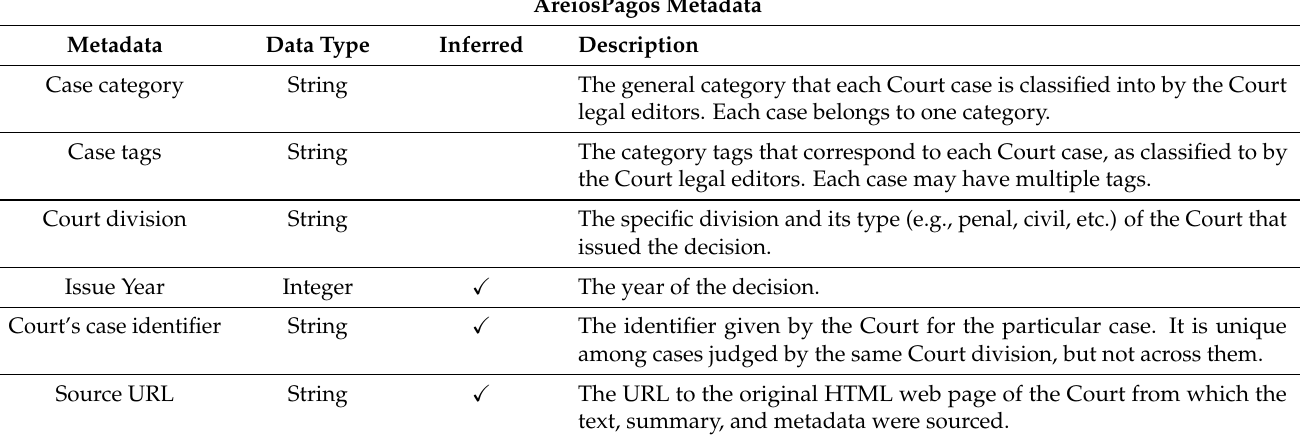
Table 2. Metadata of the Supreme Civil and Criminal Court judgments’ (AreiosPagos) dataset. Metadata that were automatically inferred, using the judgments’ main text, are labeled with a (cid:88) in the Inferred